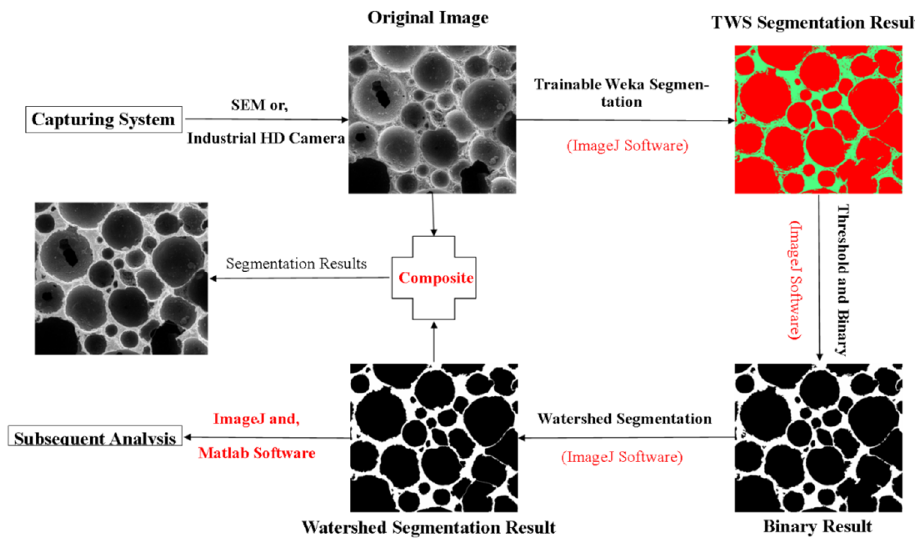
Figure 6. Image processing procedure.